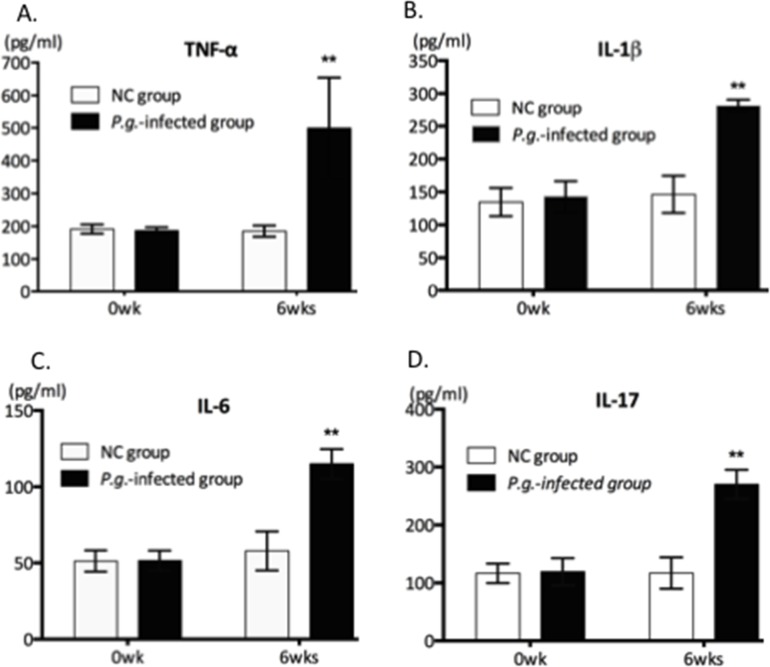
Dental Infection of P.g. Increases Pro-inflammatory Cytokines in Serum.ELISA analysis of TNF-α (A), IL-1β (B), IL-6 (C) and IL-17 (D) concentrations in serum (0wk or 6wks post-infection) of non-infected control (NC) and P.g.-infected groups (n = 6 for each). Statistical significance was determined using the Student t-test. **P<0.01.